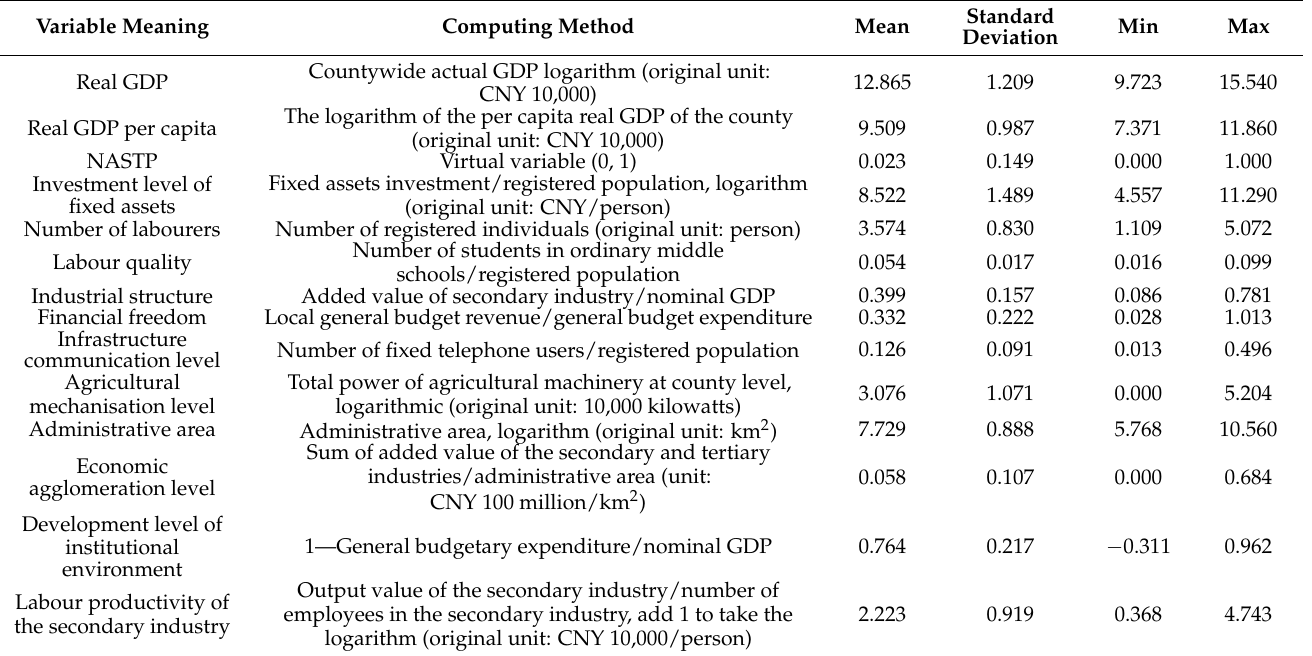
Table 2. Calculation methods and descriptive statistics of main